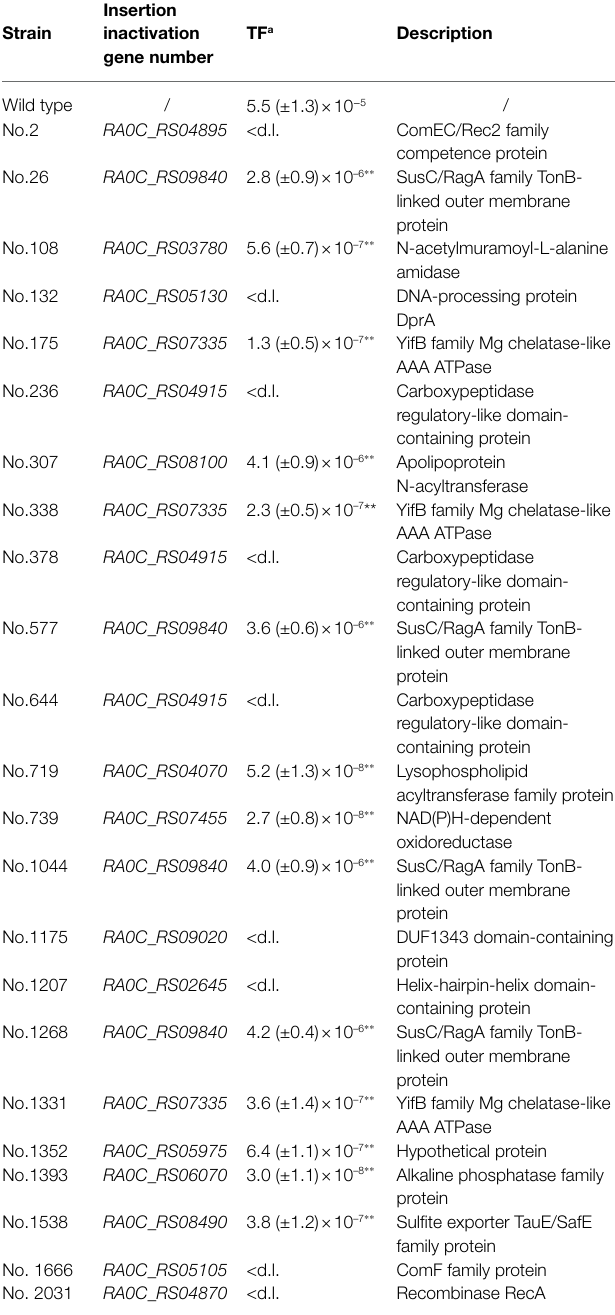
TABLE 1 | Description of natural transformation-defective R. anatipestifer